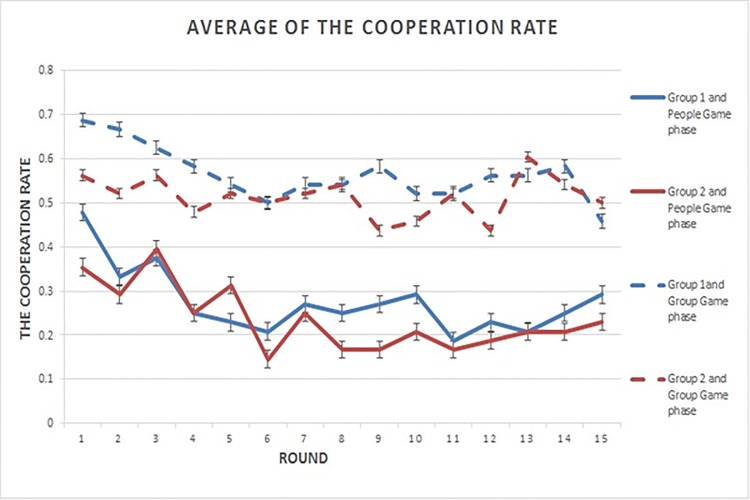
Average of the Cooperation Rate.The cooperation rate (y-axis) as a function of round or time (x-axis). Solid blue lines indicate average cooperation rate over time for Group 1 and People Game phase (average is taken for 6 experiments (socialization treatment)), solid red lines—for Group 2 and People Game phase, dotted blue lines—for Group 1 and Group Game phase, and dotted red lines for Group 2 and Group Game phase. Error bars represent standard error (SE).